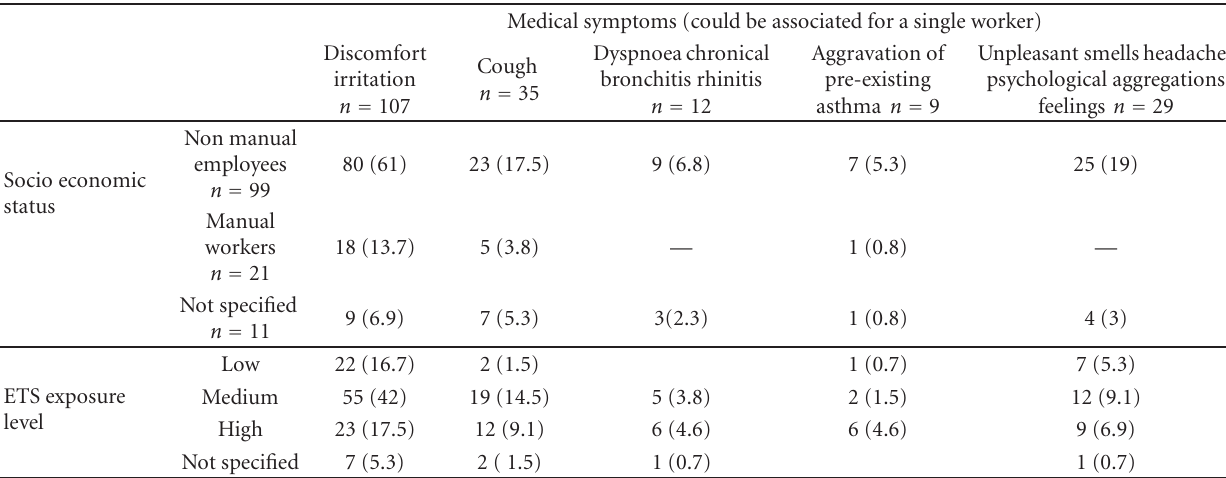
Table 2: Medicals symptoms in relationship with socioeconomic status and ETS exposure levels